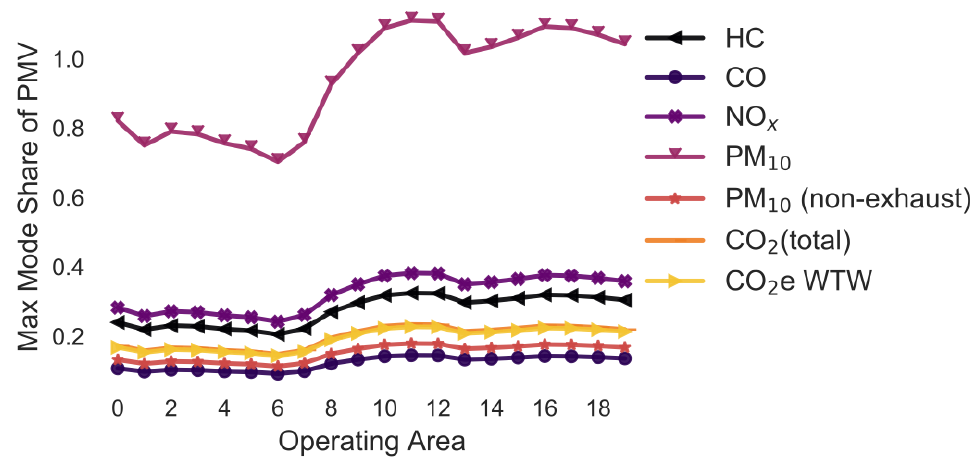
Figure 7. Maximum share of customers who can pick up a parcel by car (varying vehicle fleet age) (note: CO 2 (total) and CO 2 e WTW are the same).